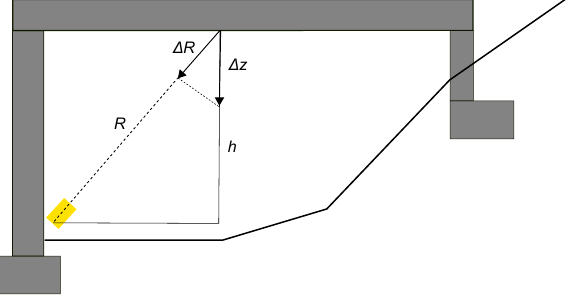
Figure 2. Schema of the measuring principle of the GBR exem- plary illustrated for bridge A. R is the distance in LOS between each range bin and the GBR, h the height difference between the GBR and the lower side of the bridge. ∆ R represents the measured displacement in LOS and ∆ z is the respective vertical projection. Figure 3. SNR values of all range bins. The highlighted range bins 19 , 21 , 22 and 24 are characterised by high